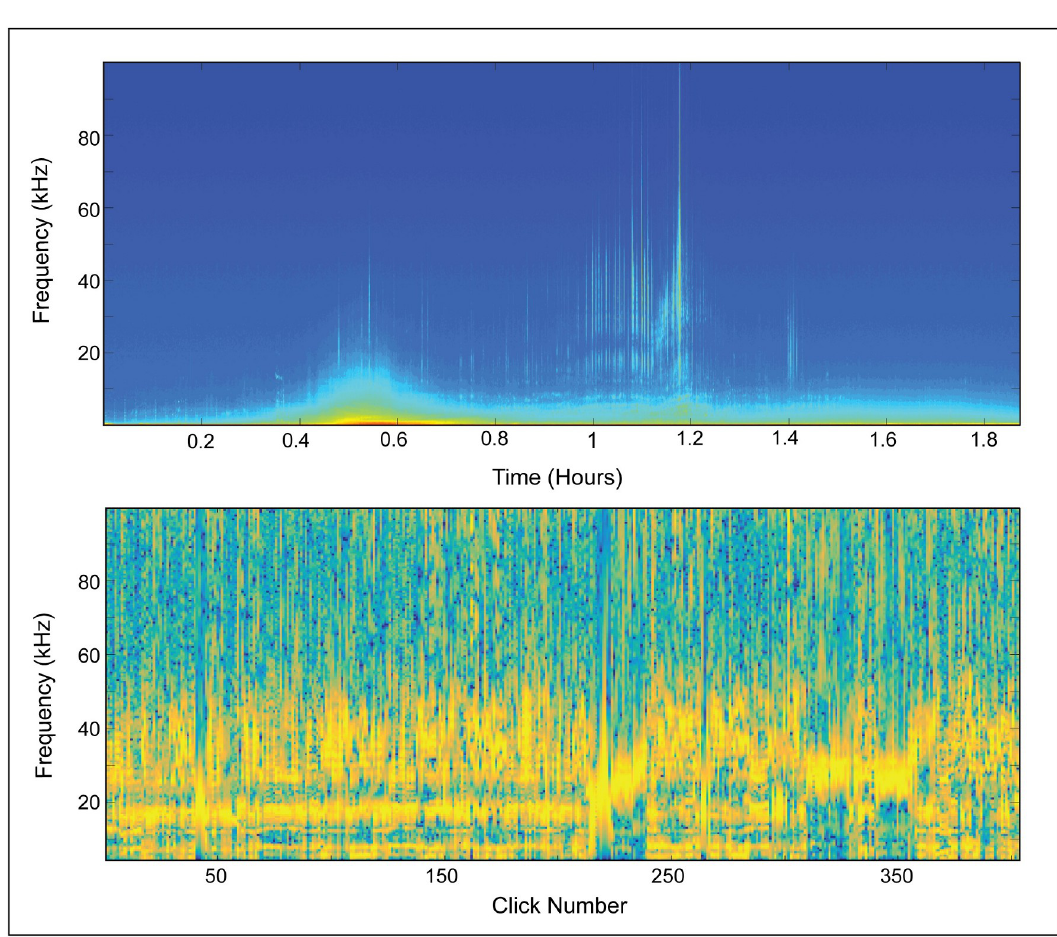
Fig 12. Visually confirmed short-finned pilot whale bout. Top panel: long-term spectrogram showing an acoustic encounter with visually-identified short-finned pilot whales at the JAX acoustic monitoring site. Bottom panel: concatenated spectra of clicks detected between 00:59 and 01:07. Most of these clicks exhibit spectral features consistent with UD26, though some natural variability is visible. In both plots the magnitude of the frequency is represented by color such that warmer colors show greater magnitude.